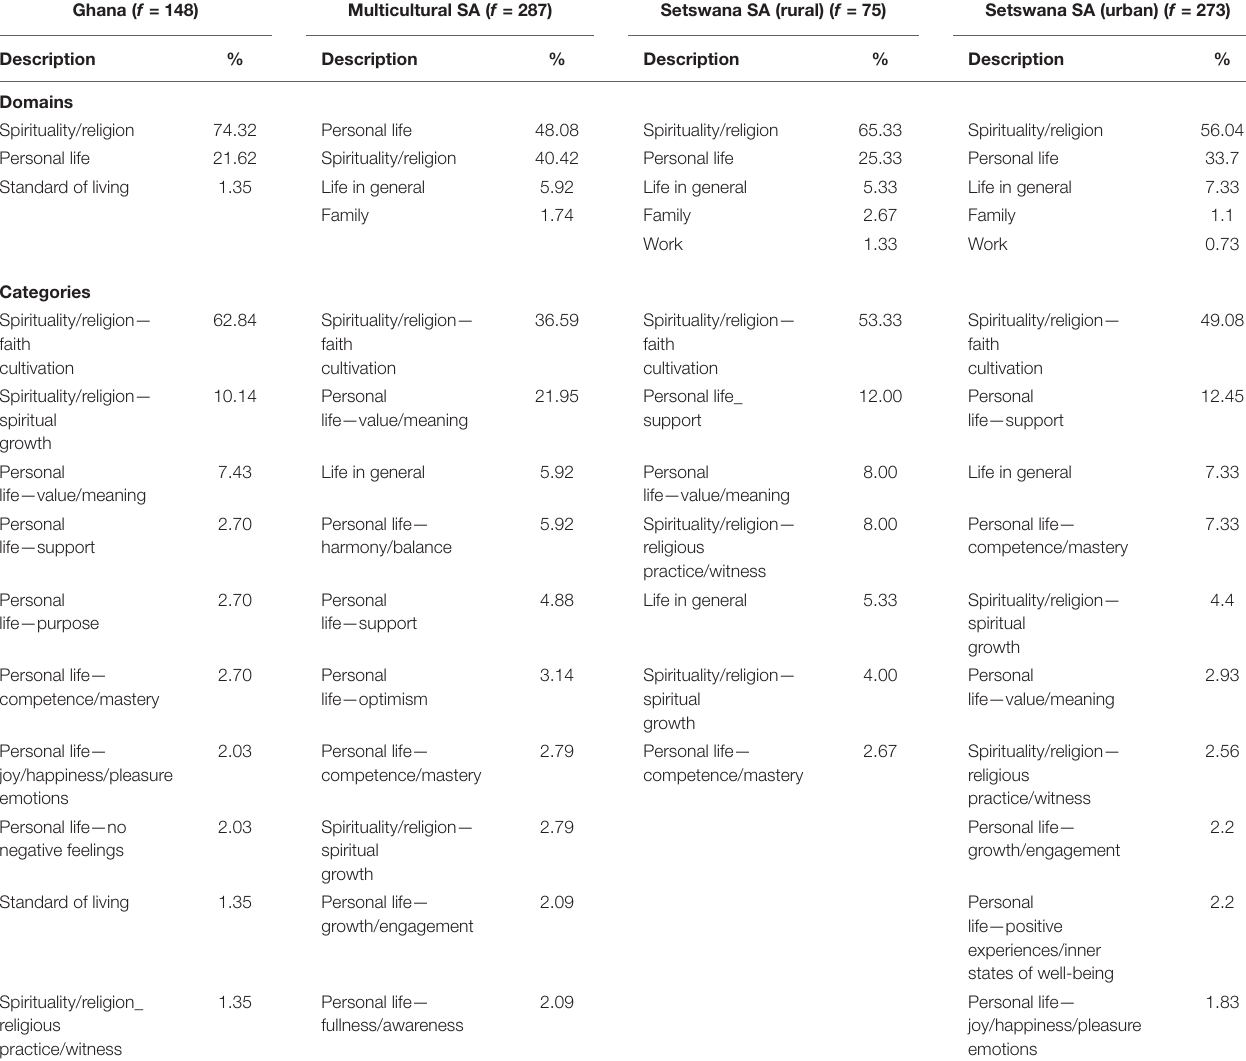
TABLE 7 | Percentages of the most frequent domains and categories in the motivations for meaning sources in the spirituality/religion domain of life. Ghana ( f = 148) Multicultural SA ( f = 287) Setswana SA (rural) ( f = 75) Setswana SA (urban) ( f =